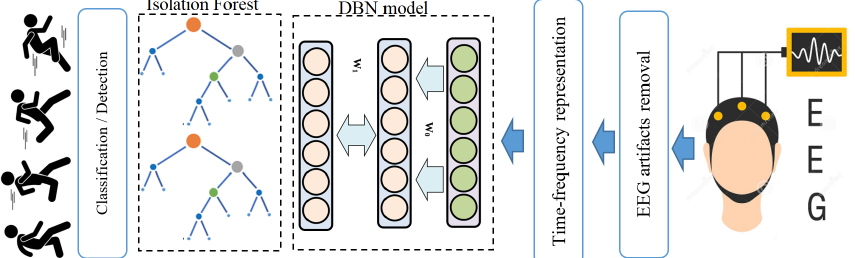
Figure 1. Schematic representation of the general deep learning framework for EEG-based metal tasks